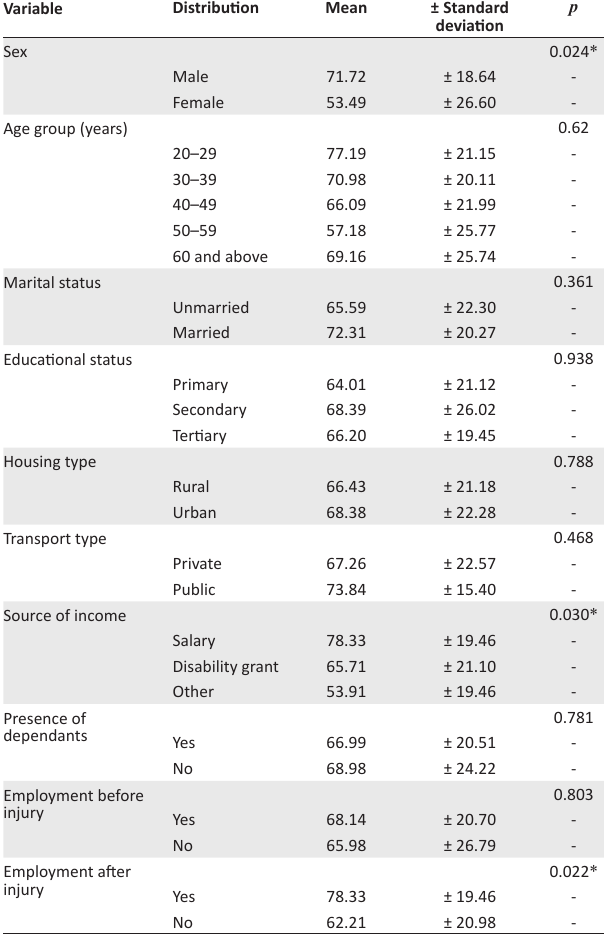
TABLE 3: Association between socio-demographic or clinical variable and Reintegration to Normal Living Index visual analogue scale % ( n = 41). Variable